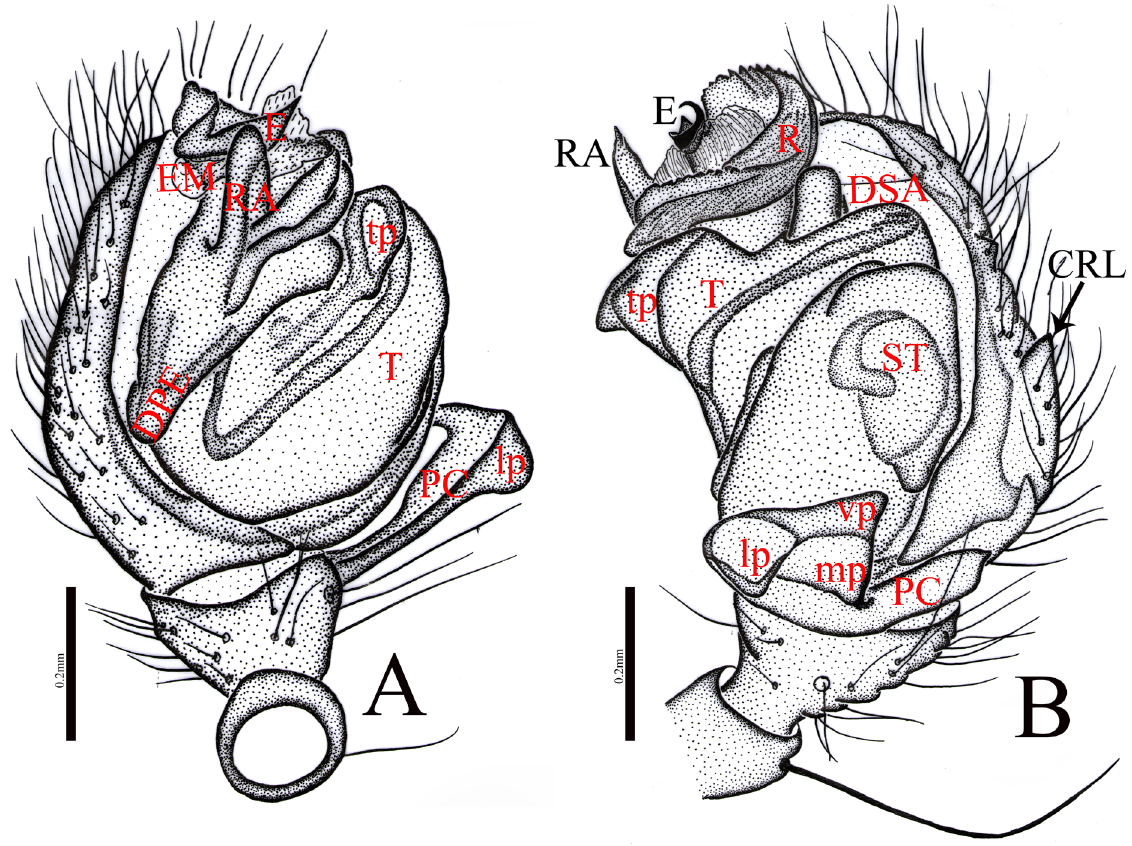
Fig. 12. Acroterius camur gen. et sp. nov., ♂, holotype (HNU-DHK–2002–038), palp. A . Prolateral view. B . Retrolateral